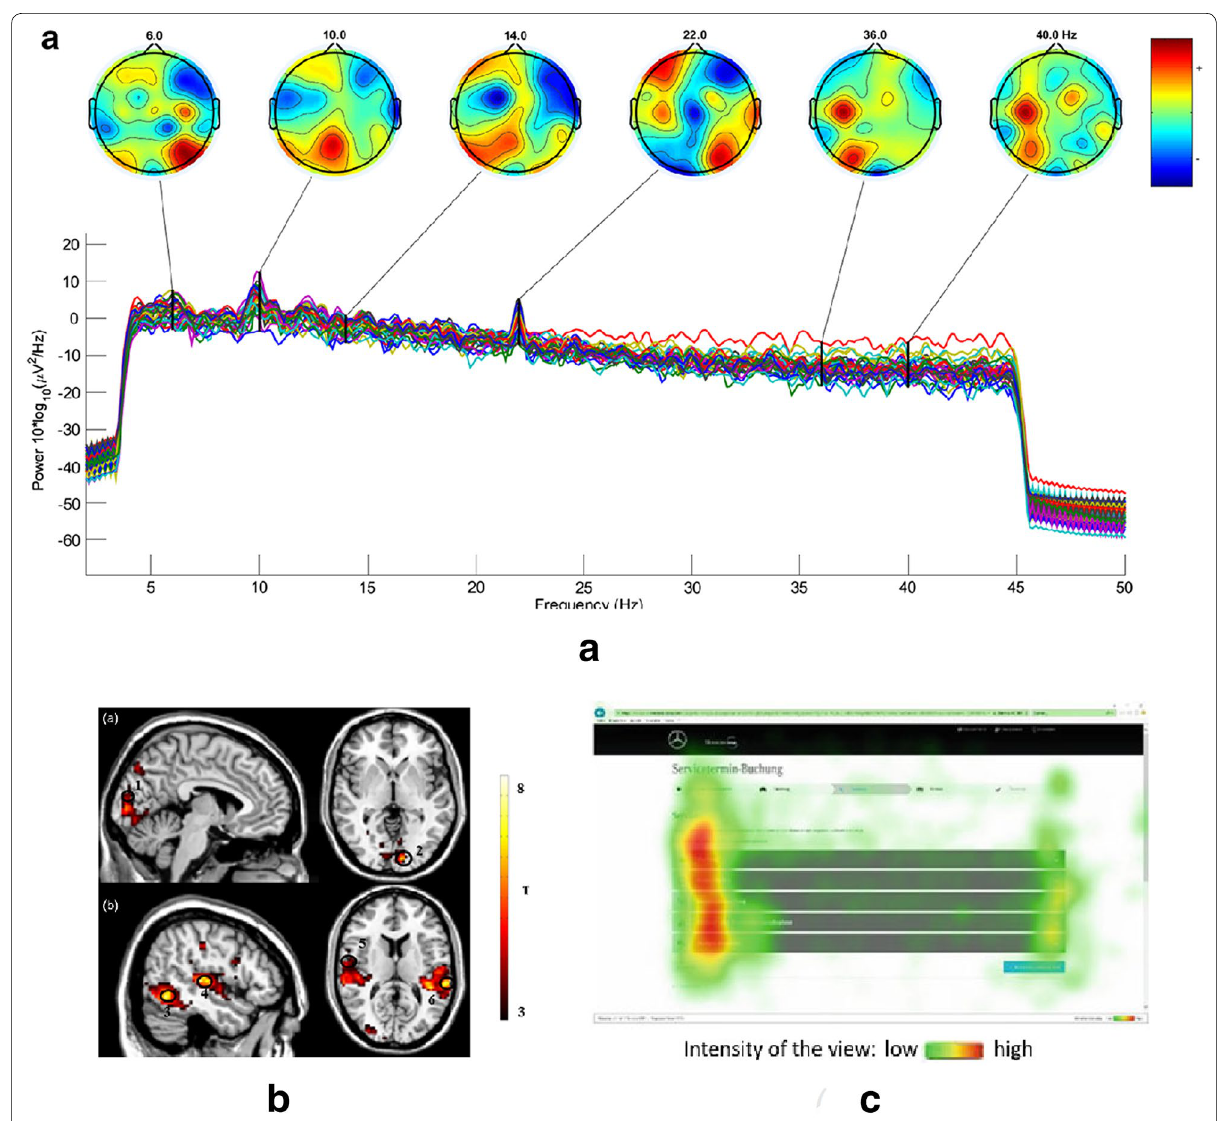
Fig. 1 Neural recording in Neuromarketing experiments: a multichannel EEG [43], b fMRI imaging [50], and c eye tracking for online booking appointment